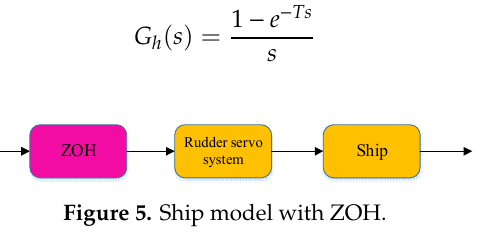
Figure 5. Ship model with ZOH.